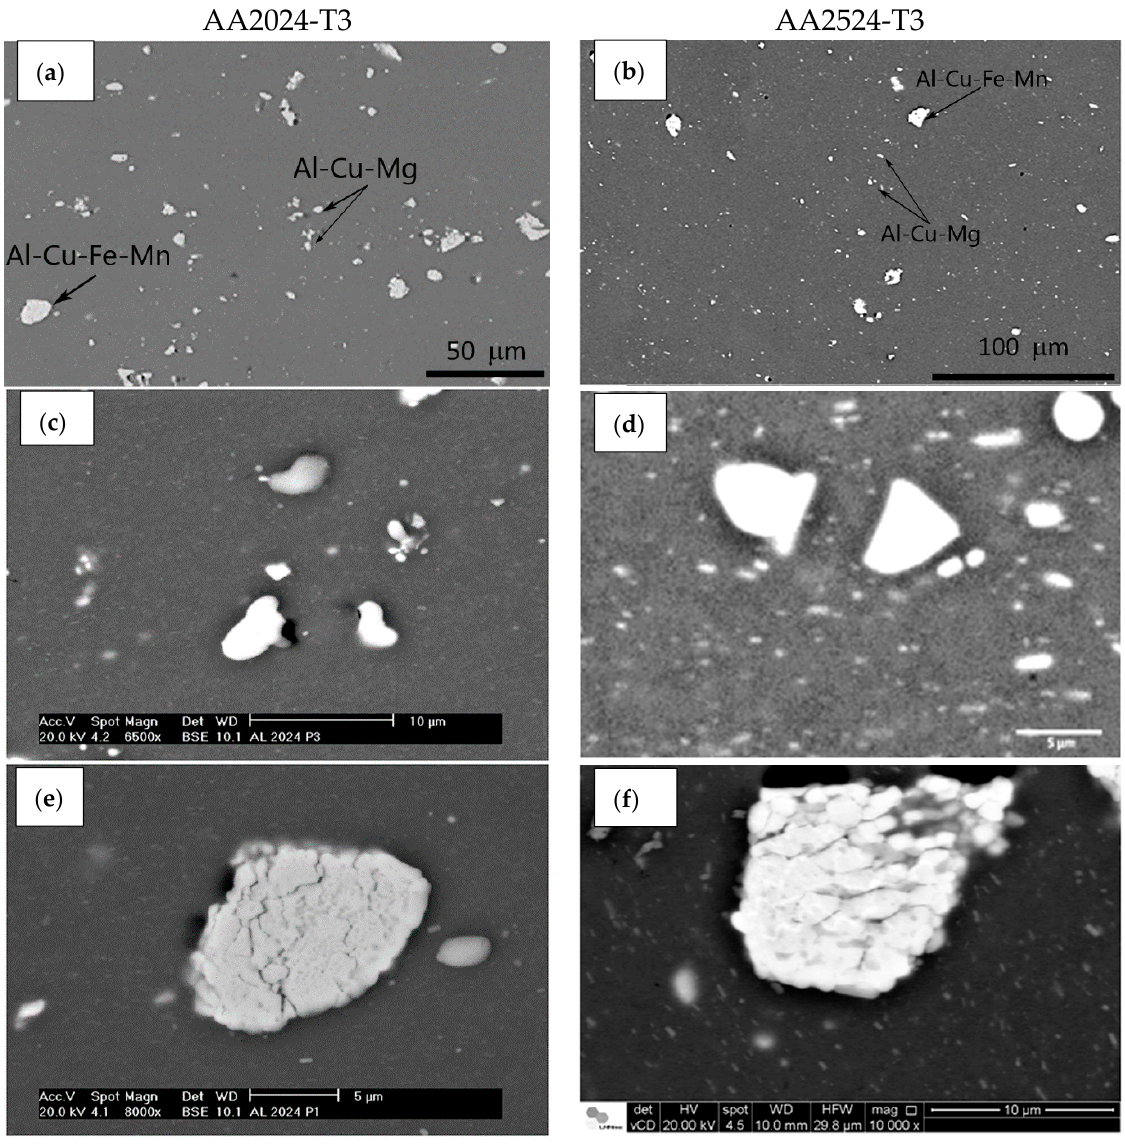
Figure 2. Microstructures of AA2024-T3: ( a ) general view; ( c ) Al-Cu-Mg; and ( e ) Al-Cu-Mn-Fe-(Si) particles. Microstructures of AA2524-T3: ( b ) general view; ( d ) Al-Cu-Mg; and ( f ) Al-Cu-Mn-Fe-(Si) particles. As-received condition. SEM–BSE.